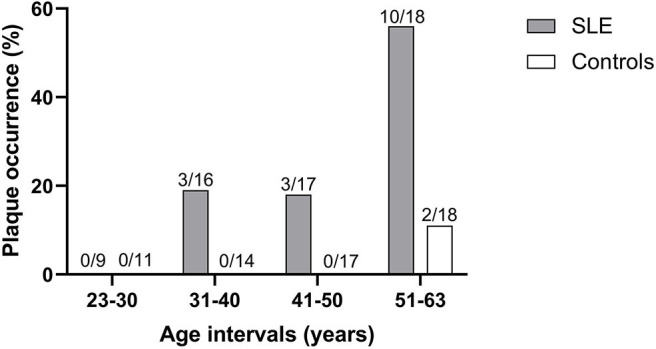
The occurrence of plaques among patients and controls shown in relation to age groups.